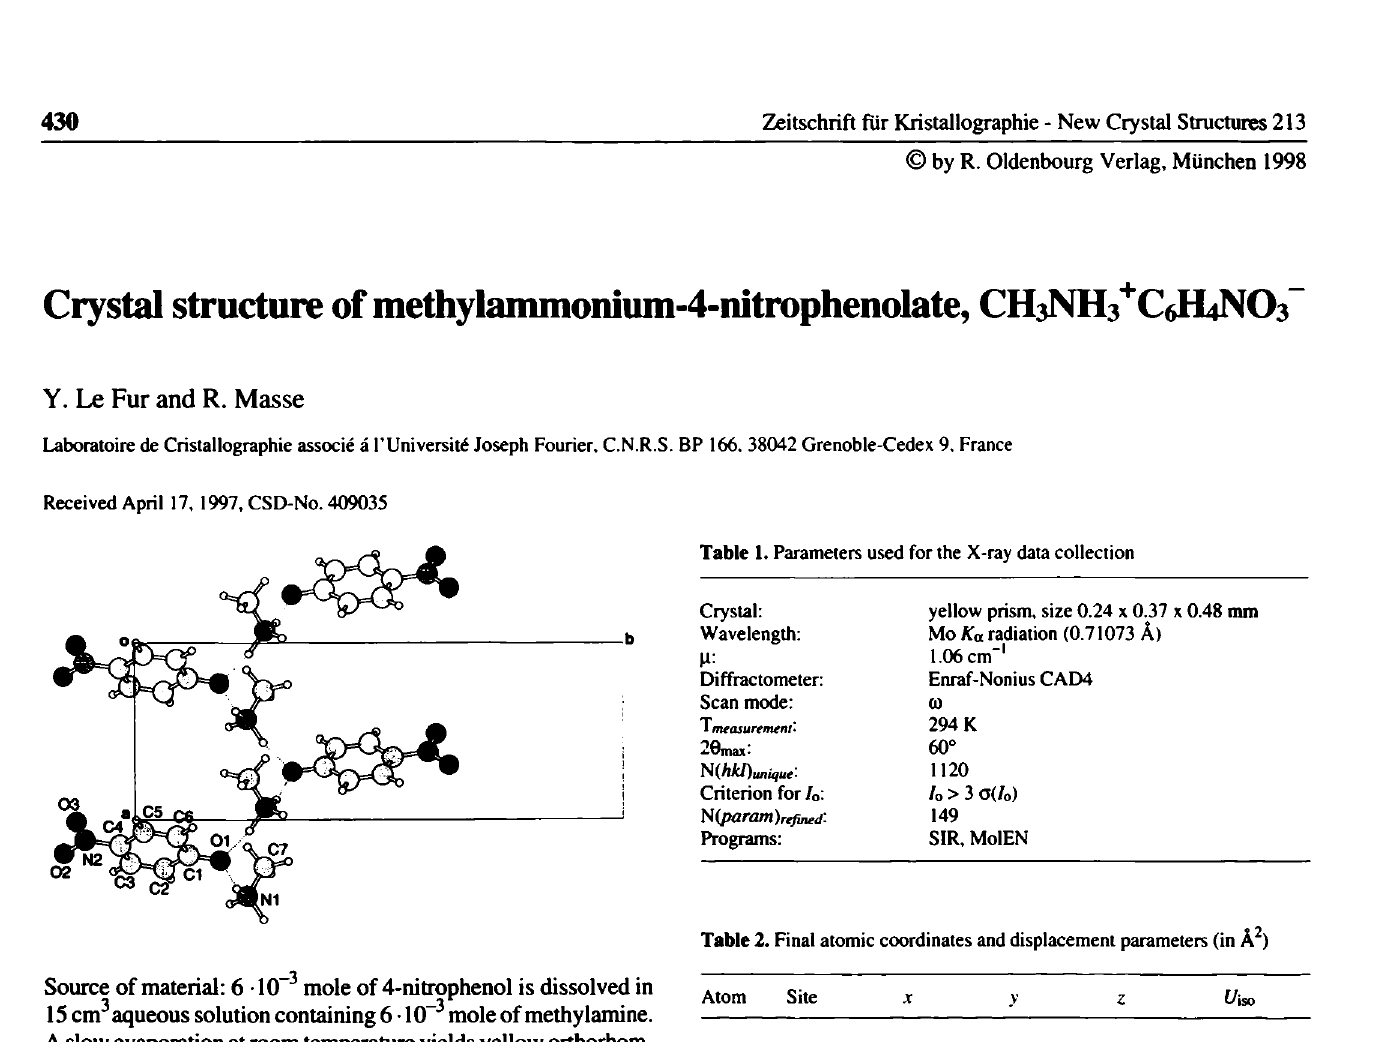
Table 2. Final atomic coordinates and displacement parameters (in Â^)